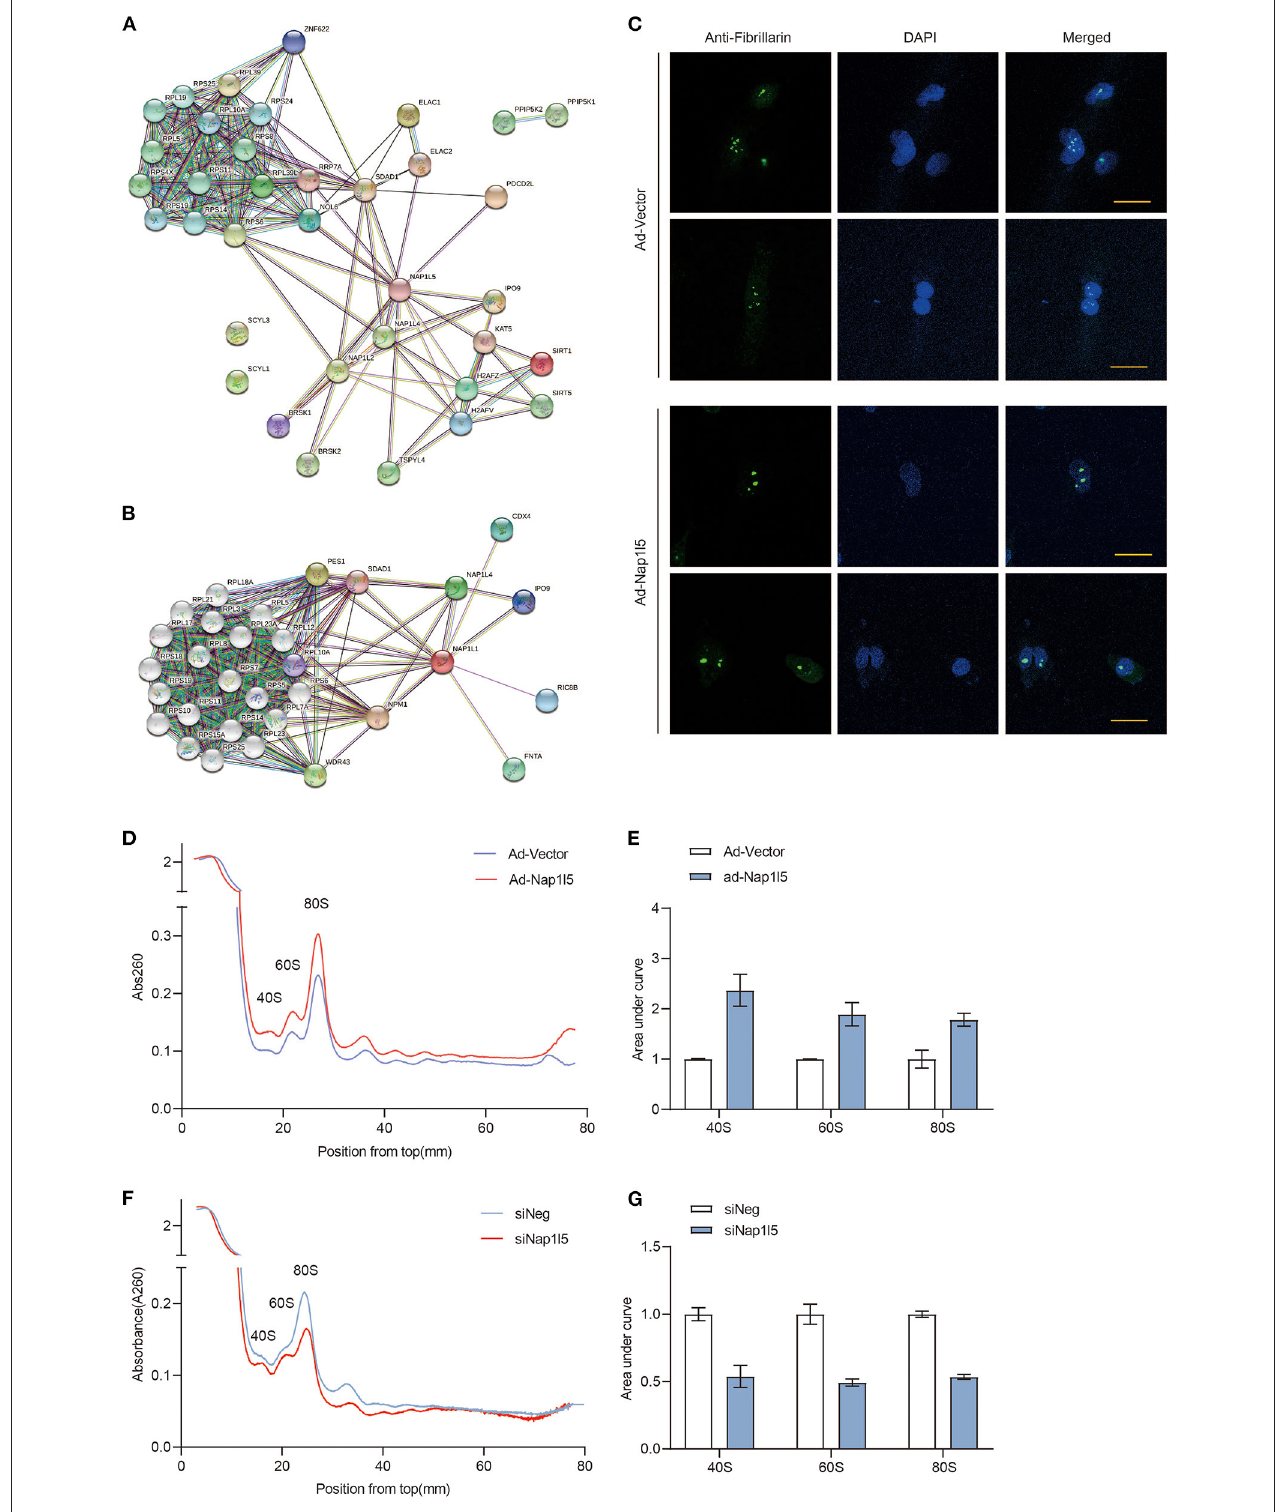
FIGURE 6 | NAP1L5 promotes nucleolar hypertrophy and ribosome assembly. (A) Protein-protein interaction (PPI) network of NAP1L5 organized from String database. (B) PPI network of NAP1L1 organized from String database. (C) Representative nucleolar immunofluorescence images using anti-Fibrillarin antibody in NRVMs infected with Ad-Vector or Ad-Nap1l5. n = 15. (D) Ribosome profiles from NRVMs infected with Ad-Vector or Ad-Nap1l5 using sucrose gradient and